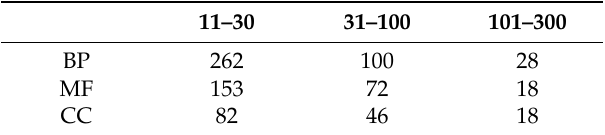
Table 2. Number of Gene Ontology (GO) terms by the number of annotated genes in human biological process (BP)/molecular function (MF)/cellular component